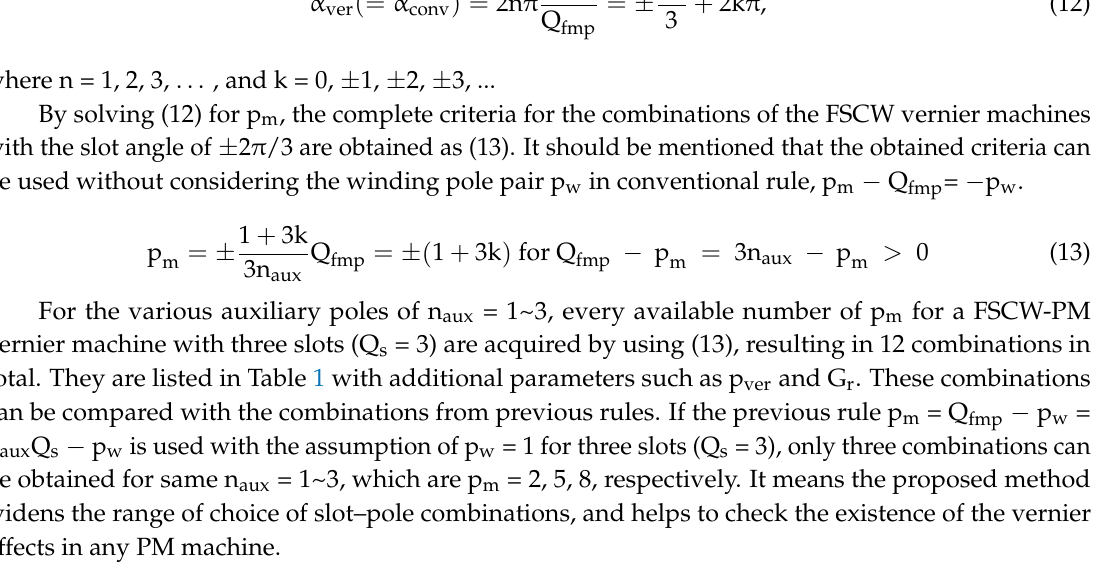
Table 1. Proposed p m (PM pairs) for a three-slot FSCW vernier motor with various n aux. Aux. Pole Numbers n